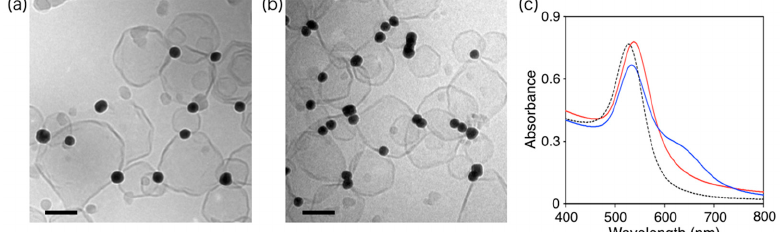
Figure 3. Cryo-TEM images of cAuNP 31 –DPPC ([cAuNP]/[liposome] = 1.67) heated at ( a ) 25 °C and ( b ) 50 °C; The scale bars are 100 nm; ( c ) UV–vis absorption spectra of solutions of cAuNP 31 (black dashed line), cAuNP 31 –DPPC at 25 °C (red solid line), and cAuNP 31 –DPPC at 50 °C (blue solid line).